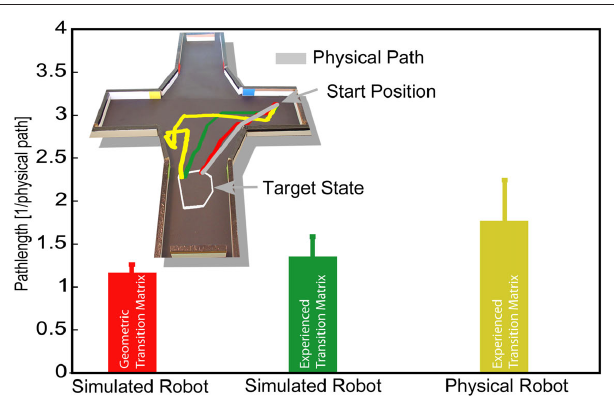
Figure  | Navigational behavior of the robot was investigated by measuring the length of the path to different goals. The direct path, defined as the shortest traversable path from the start point to the goal state (shown as the gray line in the upper part), was used to normalize the length of the robot’s path (yellow line) to the goal. The red line corresponds to the length of a path of a simulated robot by taking the topographical distribution of states (geometric transition matrix) into account. The bars represent the median length between different starting and goal states and their standard